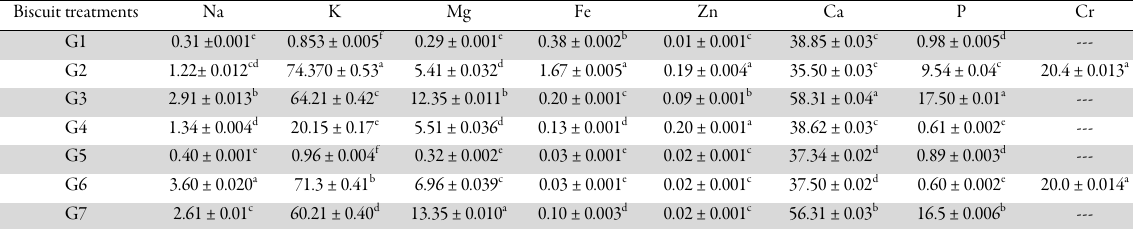
Values are mean ± SD of three-replicates Table 5. Minerals content of the colored wheat flour biscuit (mg /100g dry weight) Biscuit treatments Na K Mg